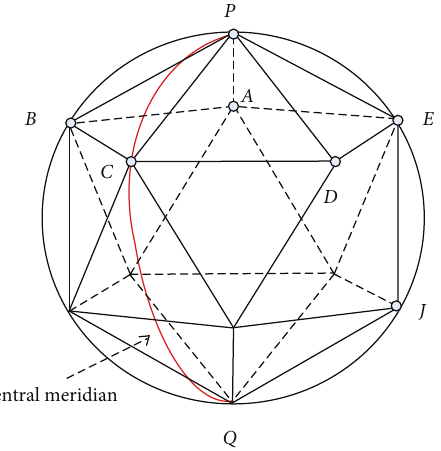
Figure 1: Positive icosahedral positioning